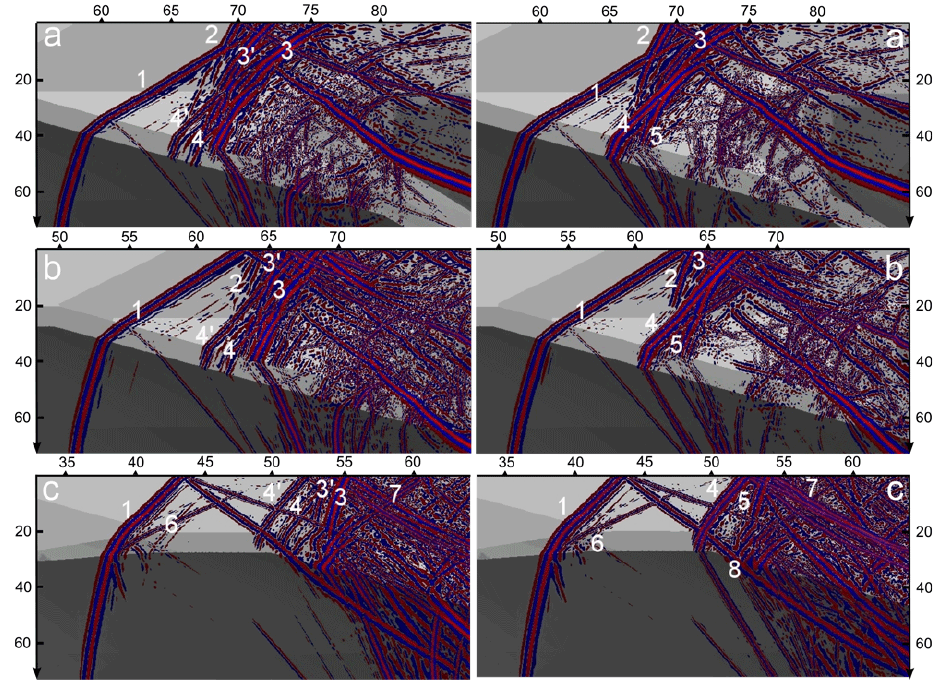
Fig. 8: Sequence of snapshots illustrating the evolution of the wave field. Left column: model with DSC; Right column: model without DSC. Vertical axis annotation gives depth in km. Horizontal axis specifies index of receivers. (a) t = 24 . 2 s, guided phases 3 have reached the surface. The direct phase still forms the first onset. (b) t = 27 . 5 s, slab-refracted wave 1 overtakes direct wave 2; phase 4 forms dominant signal in model without DSC and a secondary guided phase 5 develops in the slow serpentinized wedge; on the contrary, in the model with DSC, phases 3 form distributed signals at the surface and phases 4 stay weak. (c) t = 36 . 3 s. In the model with DSC, phases 4 overtake phases 3 and form weak precursory signals; an S conversion of phase 5 reaches the surface (phase 7). The slab refracted S conversion (phase 6) becomes visible and a reflection from the slab interface of the P surface reflection emerges. Strongest signal in model with DSC is phase 3. Phase 4 is strongest signal in model without DSC. Numbering of phases is the same as in Fig. 9. See Fig. 6 for explanation of axis labels and color shading.